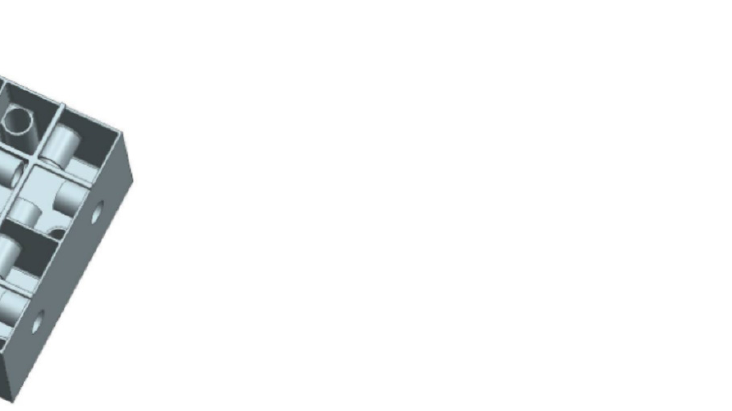
Figure 39. An AMM unit-cell for superior sound attenuation, fabricated using polyjet technology with polymer ink. The unit-cell is contained within a 50 mm wide cubic volume, with the printed prototype being 200 mm by 200 mm by 50 mm and containing 16 unit-cells [163]. (Reprinted from Procedia Engineering, Volume 176, R. Vdovin, et al., ‘Implementation of the Additive PolyJet Technology to the Development and Fabricating the Samples of the Acoustic Metamaterials’, Pages 595–599, Copyright (2017), with permission from Elsevier).